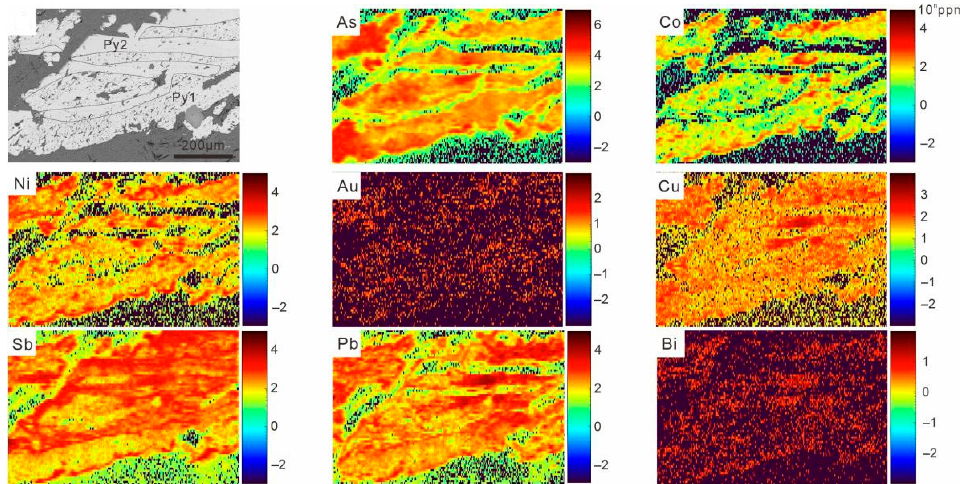
Figure 11. The LA-ICP-MS elemental mapping of Py in the Huanglonggou deposit, BSE image of the selected pyrite, other pictures: element distribution of each element.